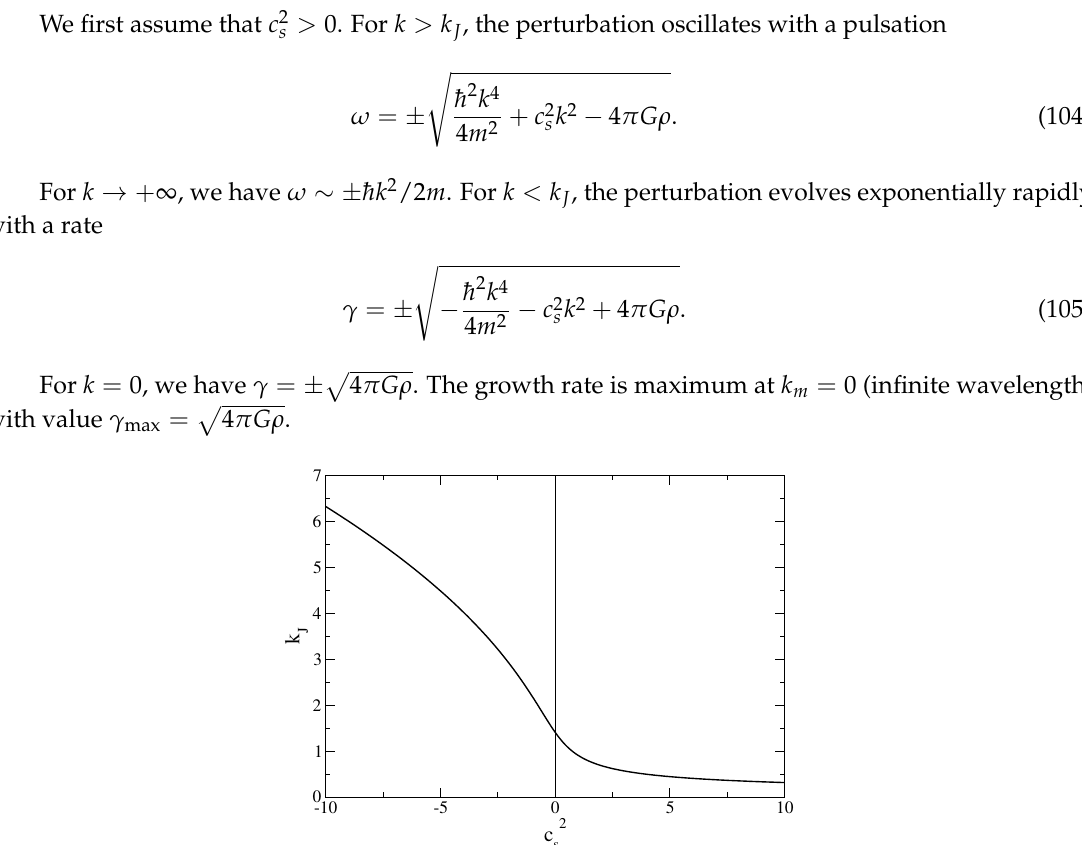
Figure 5. Dispersion relation for dissipationless self-gravitating BECs in the general case. We have normalized the wavenumber by ( 4 π G ρ m 2 /¯ h 2 ) 1/4 , the pulsation by ( 4 π G ρ ) 1/2 and the squared speed of sound by ( 4 π G ρ ¯ h 2 / m 2 ) 1/2 . This is equivalent to taking 4 π G = ρ = m = ¯ h = 1 in the dimensional equations. We have selected c 2 s = 1,0, − 1.